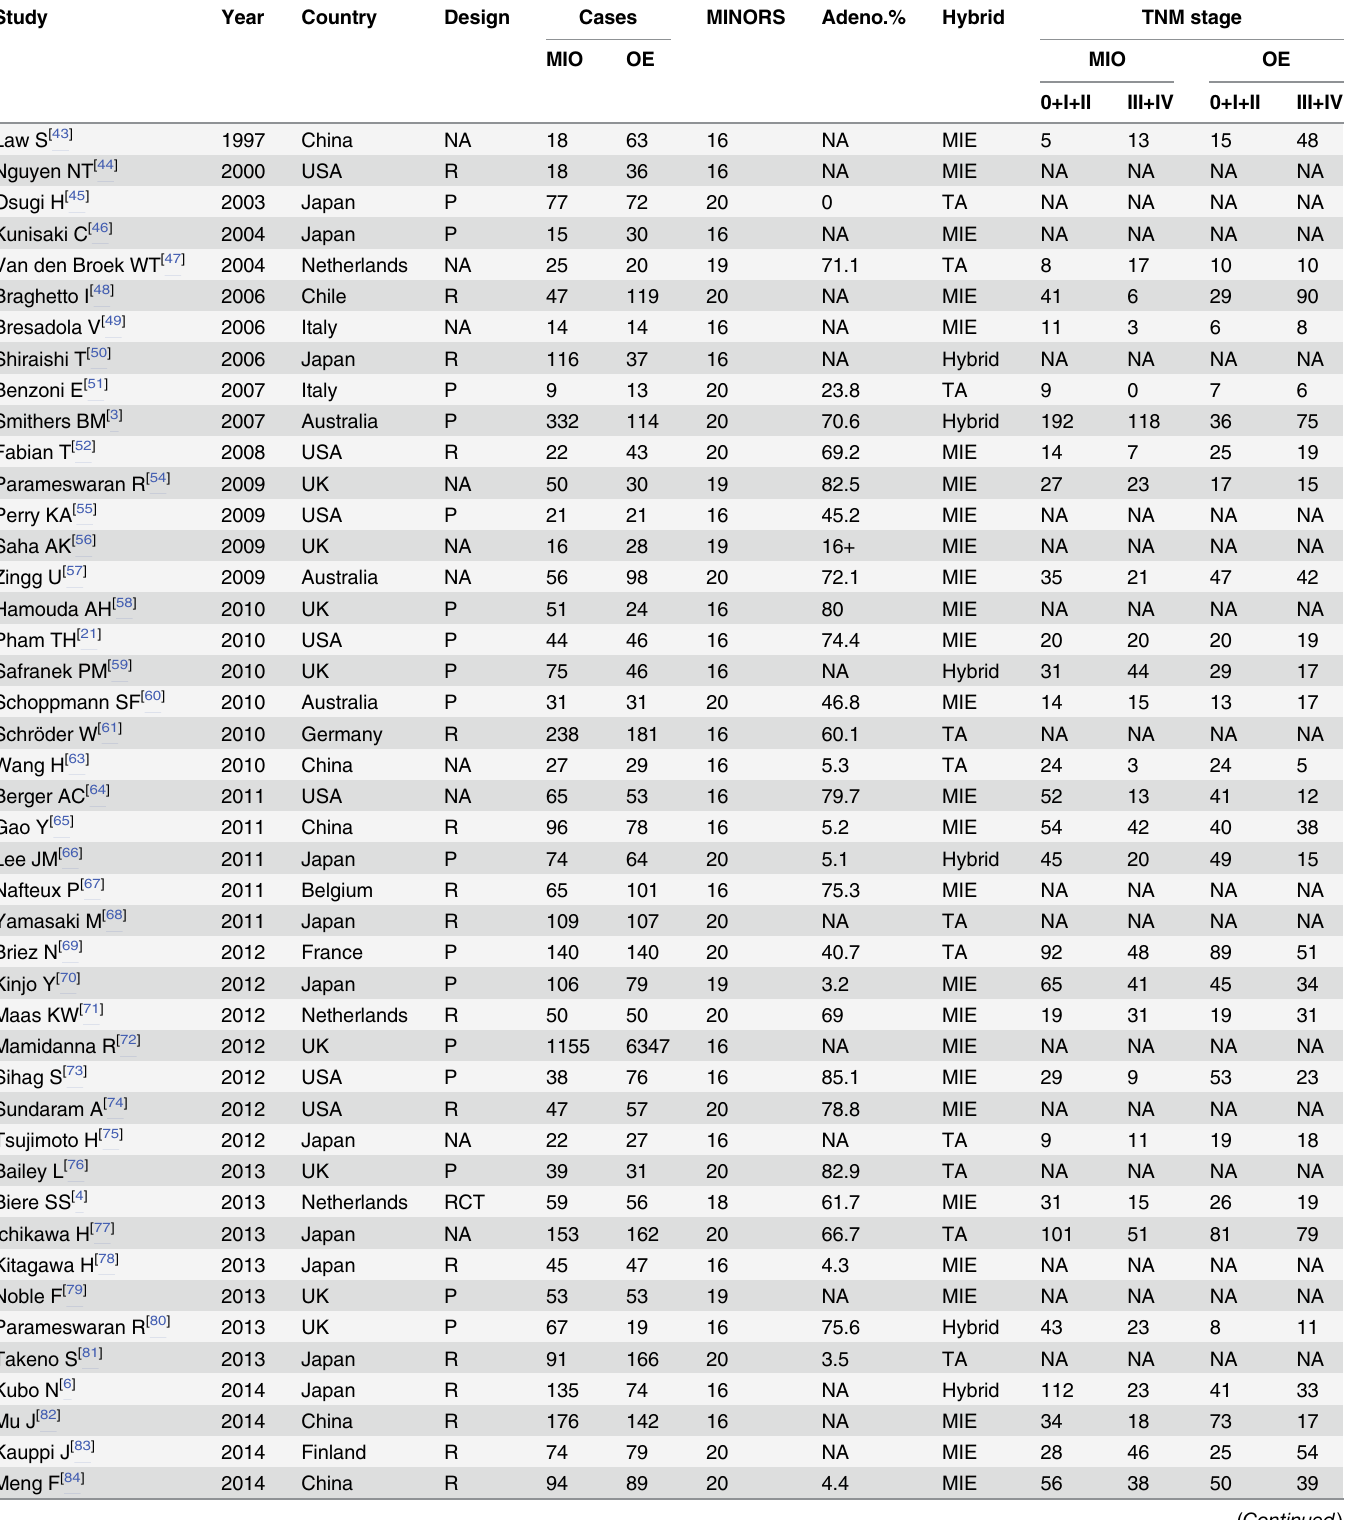
Table 1. Characteristics and Demographics of Included